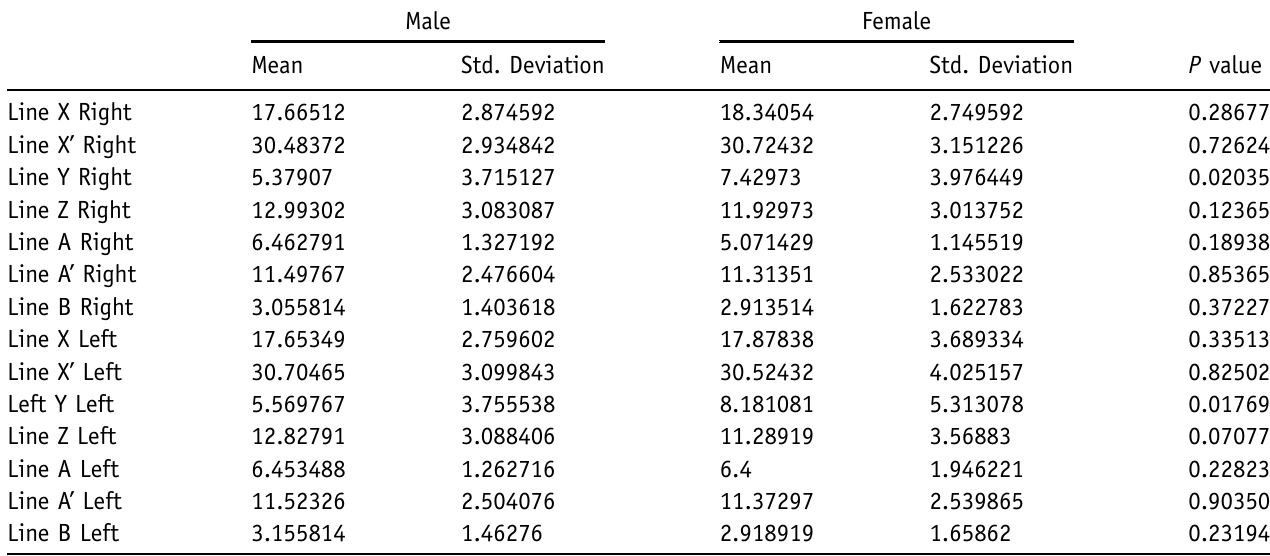
Table II. Genderwise distribution of mean, standard deviation and P value.